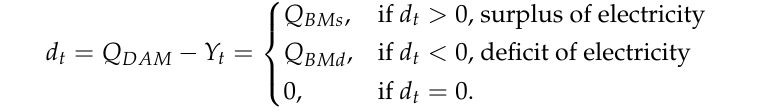
Figure 13. Hourly prices euro/MWh for the DAM and BM from the Romanian power market operator. The exchange rate for conversion to euro in Q4 2019 is 4.7665 lei/euro. https://www.bnro.ro/Raport-statistic-606.aspx accessed on 28 August